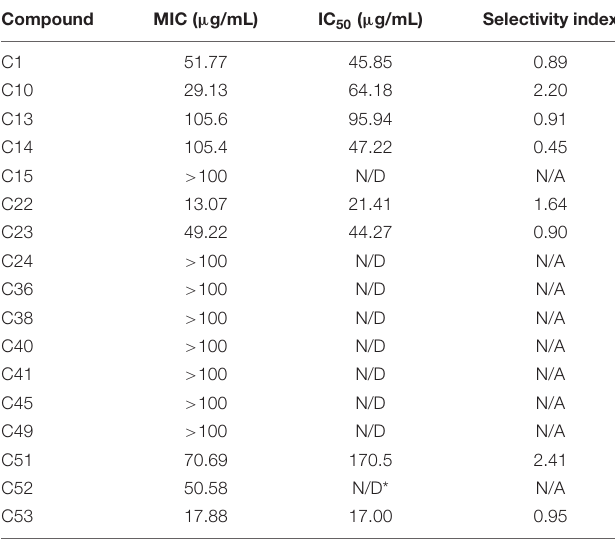
TABLE 1 | Antimycobacterial and cytotoxic activities of hit compounds against Mycobacterium tuberculosis .